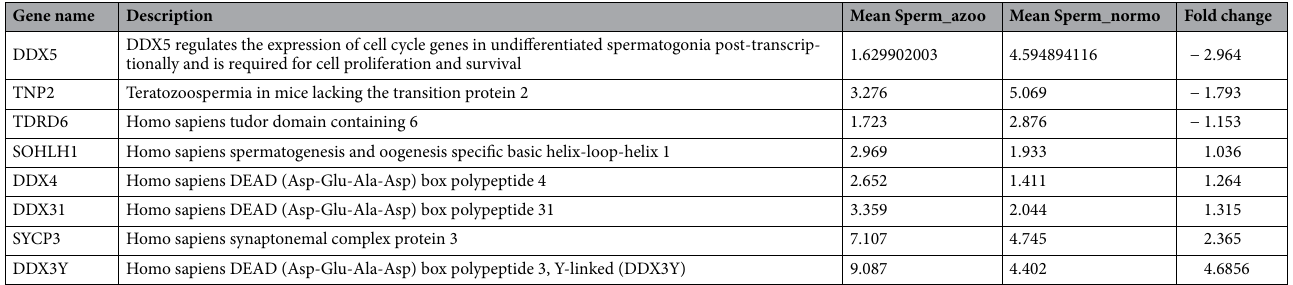
Table 2. Gene members of infertility (non-obstructive azoospermia) are differentially expressed in the normal cell.